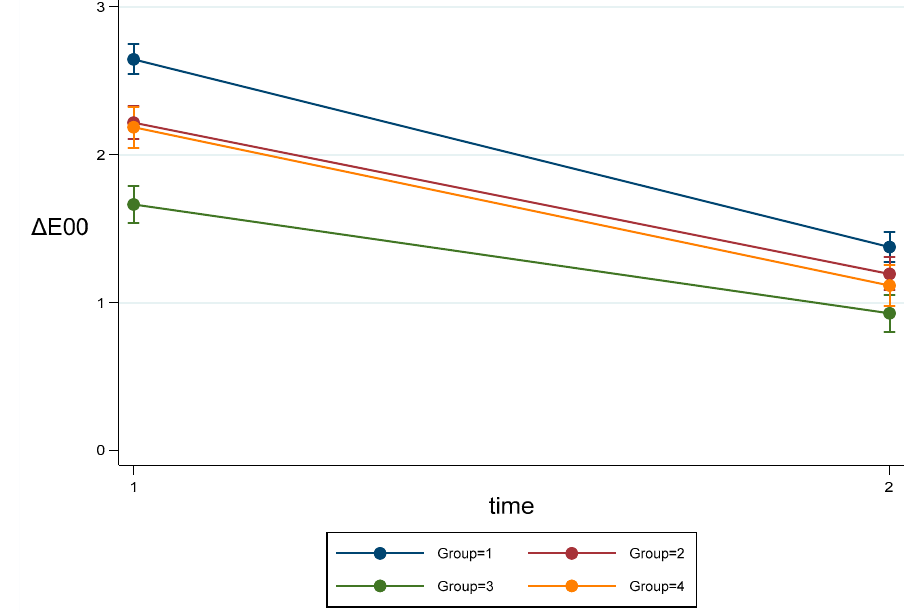
Table 5. Δ E00 Parameter: estimated means and SE from mixed model.